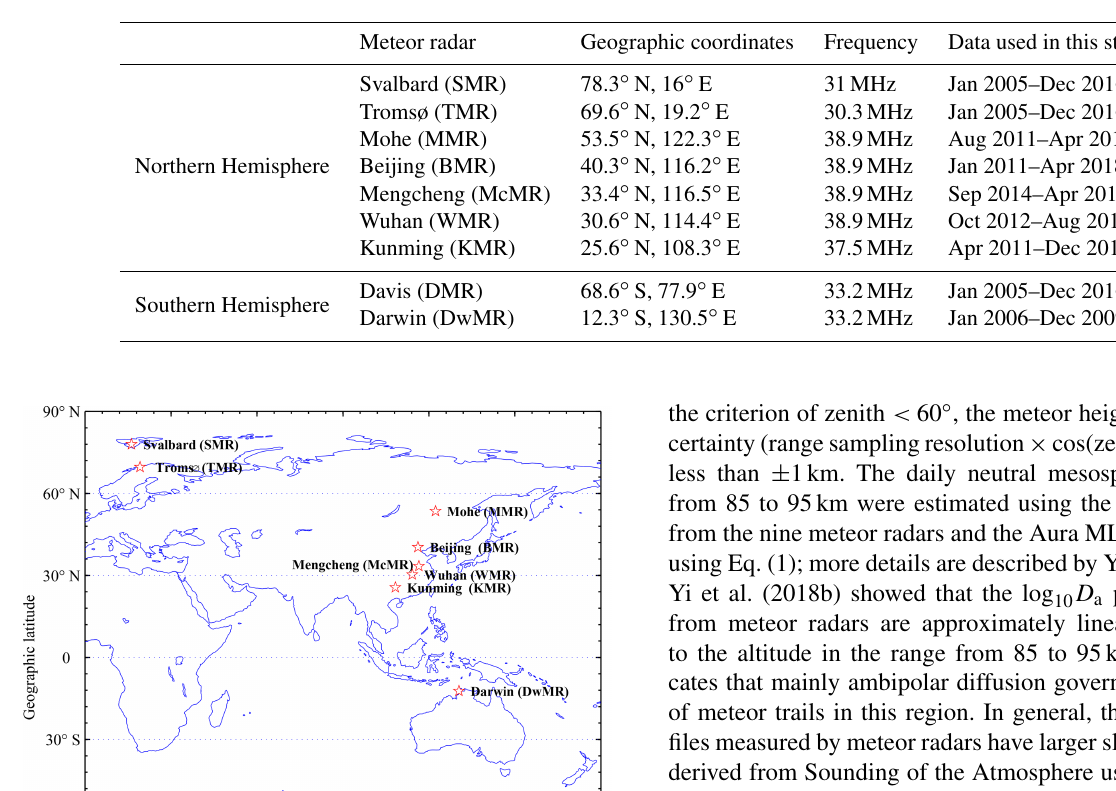
2008) and geopotential height data (version 4) were re- stricted to data obtained within a 10 ◦ × 20 ◦ bounding box centered on each of the abovementioned meteor radar loca- tions. Geometric heights, z , for Aura MLS observations were computed from geopotential heights, z g , via the equation z = z g R E (φ) [ R E (φ) − z g ] − 1 (Younger et al., 2014), where R E (φ) is the radius of Earth at latitude φ , based on the WGS84 ellipsoid (Decker, 1986). The daily averaged MLS temperature and geometric height observations were interpo- lated into 1 km bins between 85 and 95 km to produce tem- perature